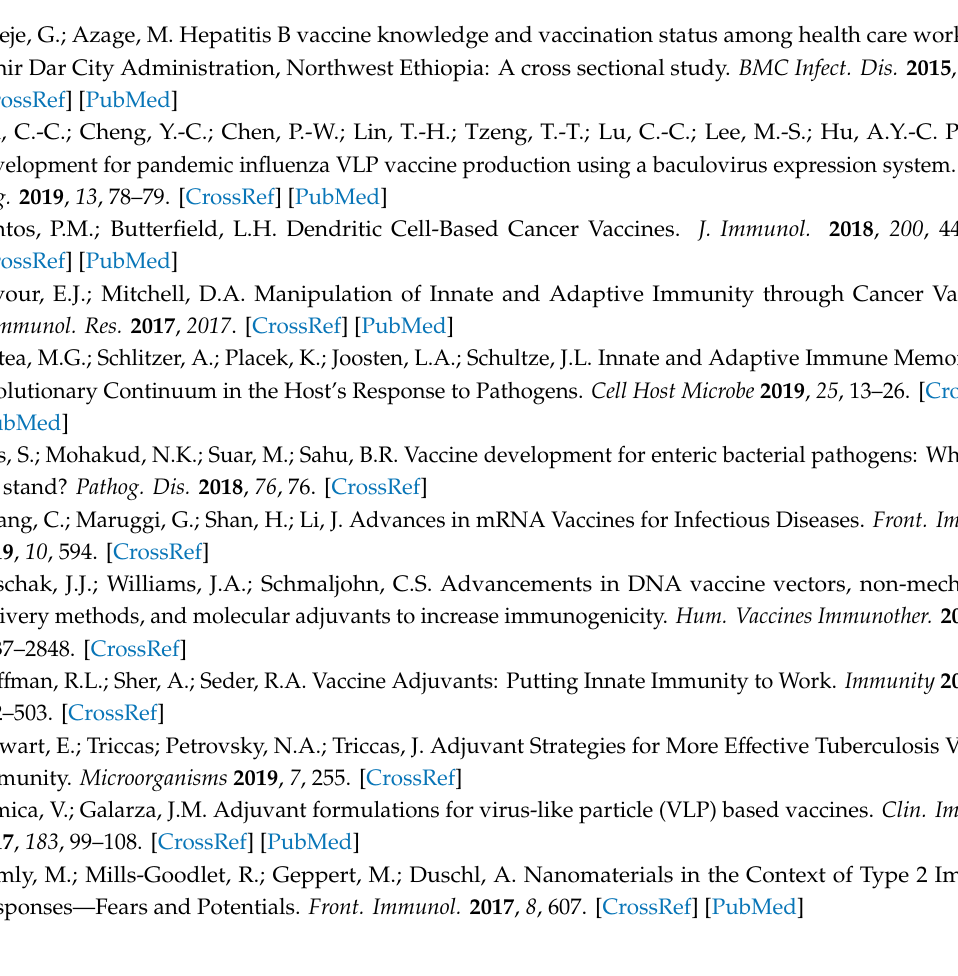
Figure S1: Flow cytometry analysis of multifunctional T